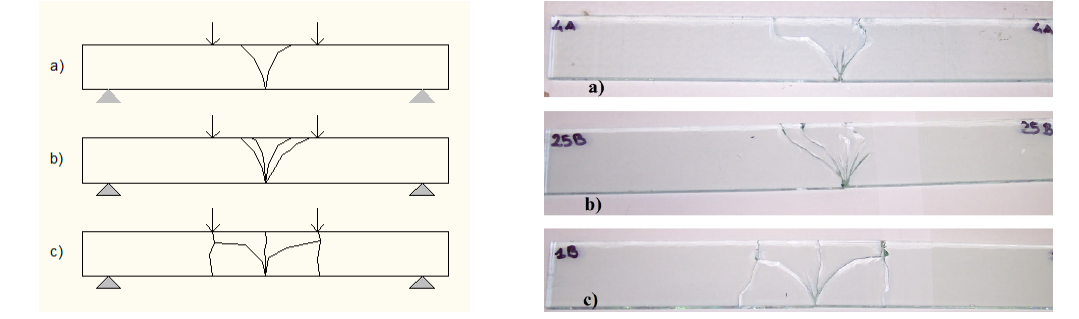
Figure 2: Crack patterns of glass beams.